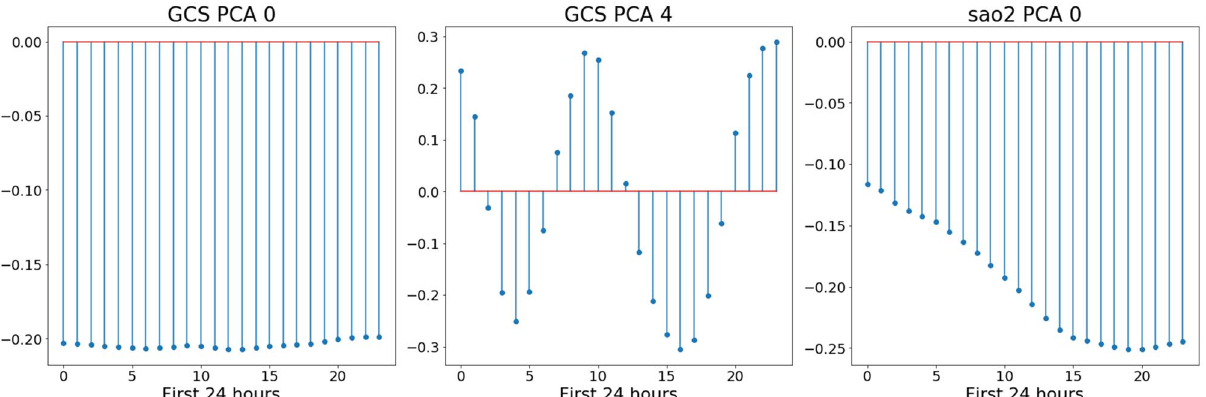
Figure 4. Principal component analysis. The plots indicate how three highly predictive principal component analysis terms (GCS component 0, GCS component 4, SaO 2 component 0) are calculated. Prior to PCA, we calculate the mean of each vital measurement for each hour of a patient’s first 24 h in ICU, resulting in vector with 24 values. These values are then normalized to have 0 mean. Each graph shows the weight applied to each of the 24 hourly values of the component to compute the PCA component value. For example, GCS component 0 is computed by multiplying the normalized motor GCS at each hour by ~ − 0.2. The component has a high value if the patient has a low motor GCS throughout the first 24 h of their stay (high value of GCS component 0 is associated with poor neurological outcome and increased mortality). SaO 2 component 0 has a high value if SaO 2 is initially slightly below average (taken across all TBI patients) and continues to decrease, where high values of the component are associated with increased mortality. Finally, GCS component 4 has a high value if motor GCS oscillates over the first 24 h, starting above average. High values of this component (fluctuating level of consciousness) are associated with favorable neurological ingful prognostication in TBI, including certain clinical features (such as pupillary reactivity), as well as infor- mation from brain imaging, which are important predictive variables in moderate and severe TBI patients 7 . In consequence, direct comparisons between our model and the IMPACT and CRASH models were not possible. Also of note, the clinical outcomes available in eICU are limited to survival status without provision of any validated post-TBI functional outcome scale such as the Glasgow Outcome Scale or Glasgow Outcome Scale Extended, and without any data beyond the time of ICU discharge. We defined an operational “neurological